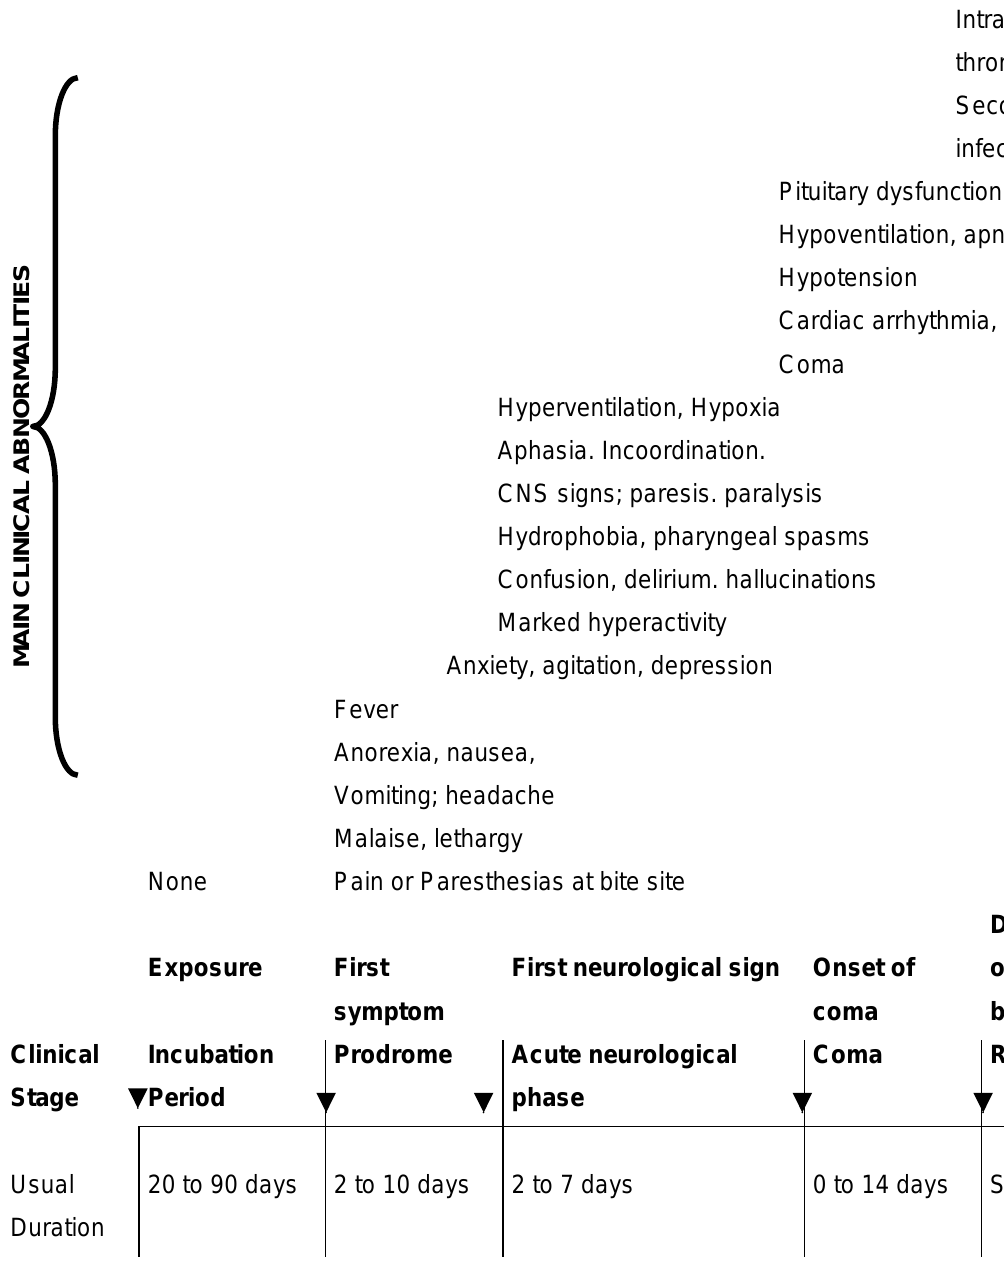
Table 1: Natural history of rabies in humans. Hypothetical composite case. Not all clinical abnormalities are necessarily present in every case. Adapted from Fishbein and Robinson